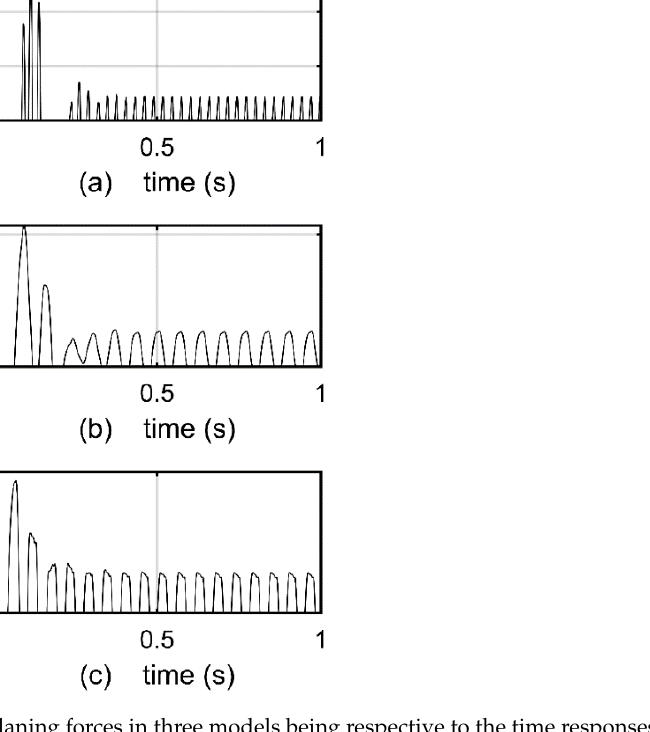
Figure 4. Planing forces in three models being respective to the time responses in Figure 3: ( a ) delay-free model; ( b ) delayed model; ( c ) FOM.